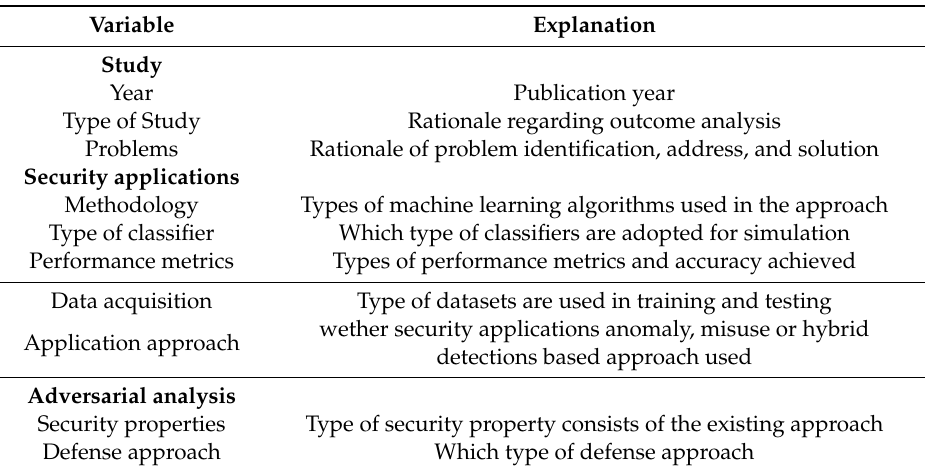
Table 2. Types of variables considered for paper selection during the